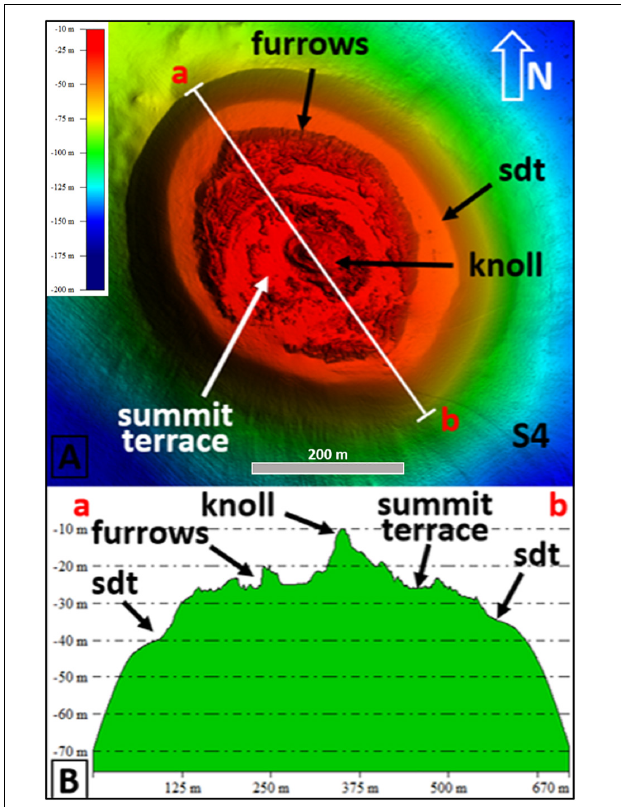
FIGURE 6 | (A) Very high-resolution shaded relief image of S4 shoal (Ferdinandea volcano), with a NW-SE topographic profile (B) well imaging the knoll, furrows, summit terrace and submarine depositional terrace (SDT); the SDT’s edge shallows from NW to